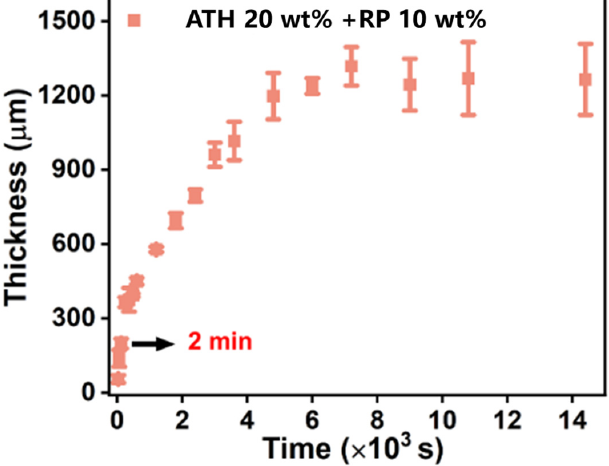
Figure 6. Growth curves of RP 10 wt.% and ATH 20 wt.%. Table 3. Performance test of the RP 10 wt.% and ATH 20 wt.% mixed system.